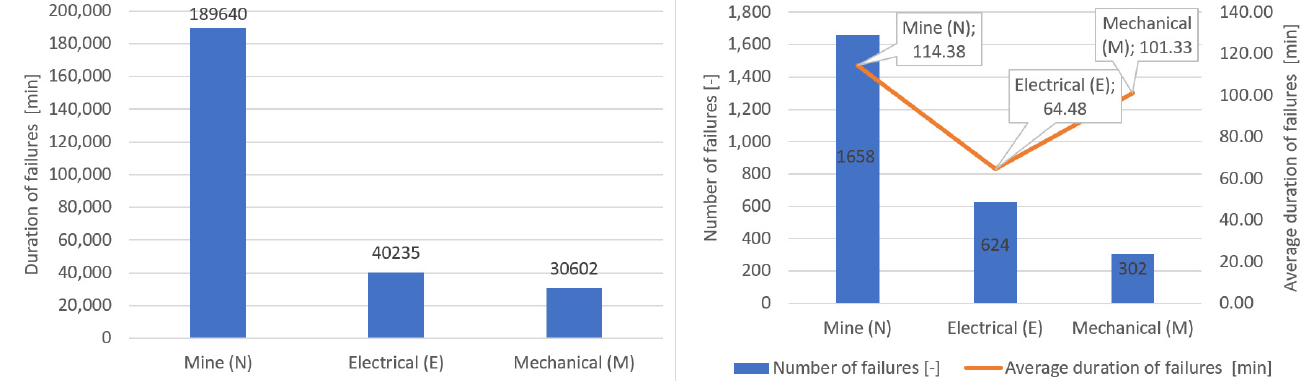
Figure 3. Total duration, number and average duration of mining, electrical and mechanical failures.